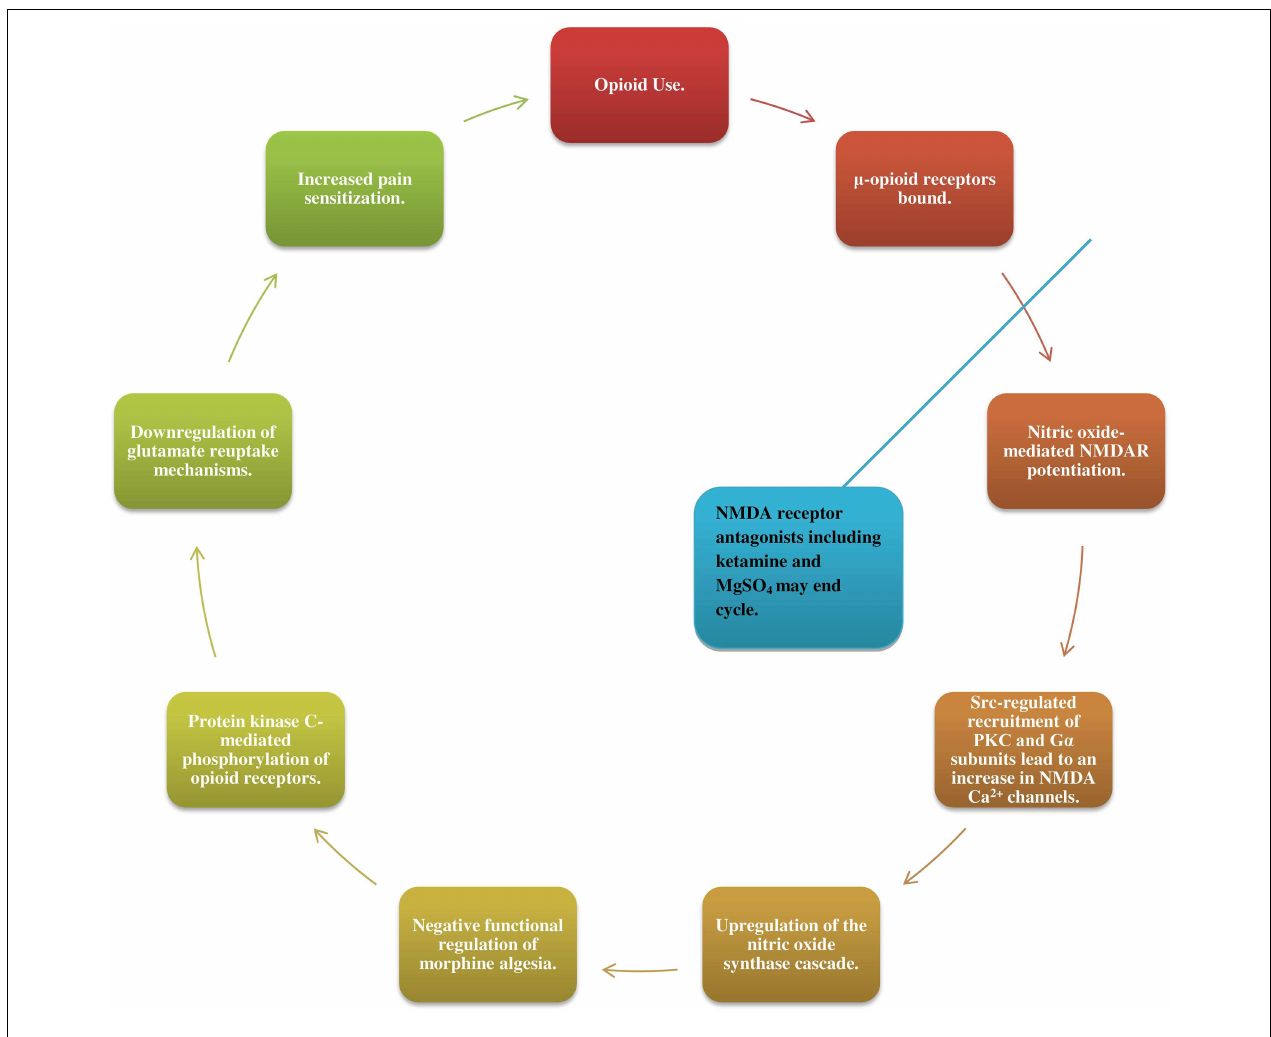
protein kinase C-mediated phosphorylation of opioid receptors and downregulation of glutamate reuptake mechanisms. Together, these changes bring about central sensitization to pain and an increased need for opioid medications, sustaining the cycle. Patients receiving NMDAR antagonists such as ketamine and MgSO 4 alongside opioids exhibited recovery of opioid analgesic